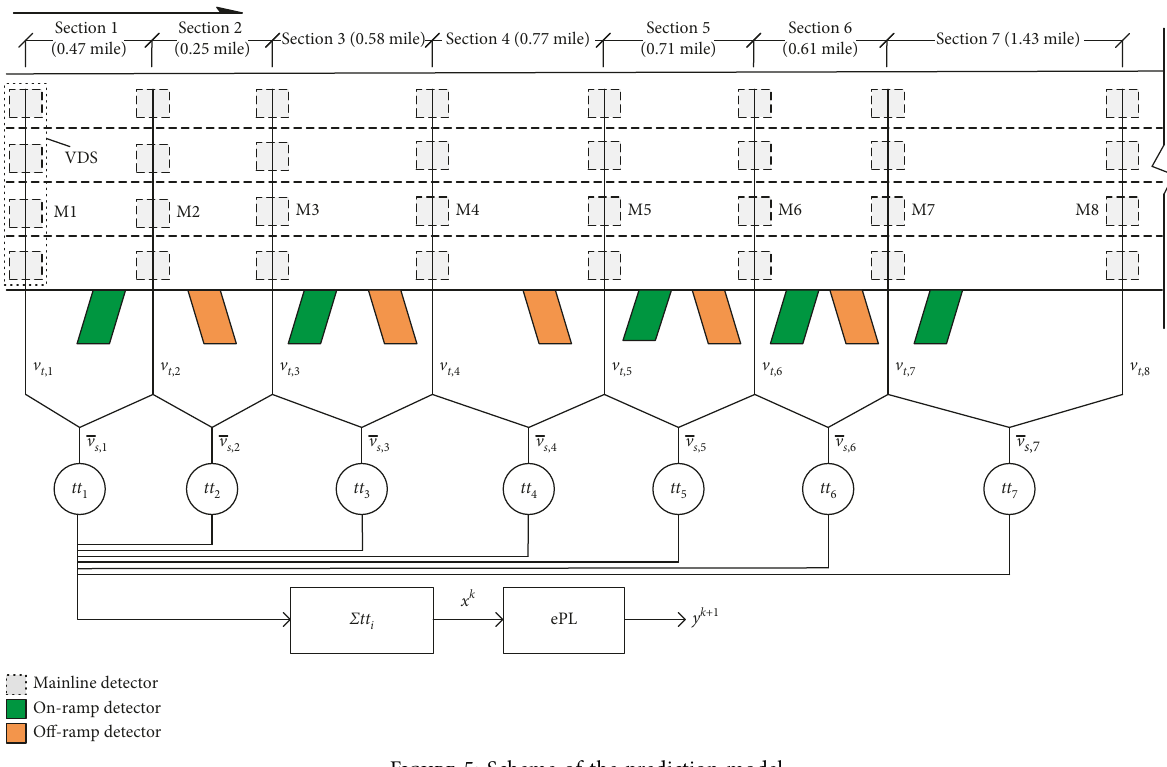
Figure 5: Scheme of the prediction